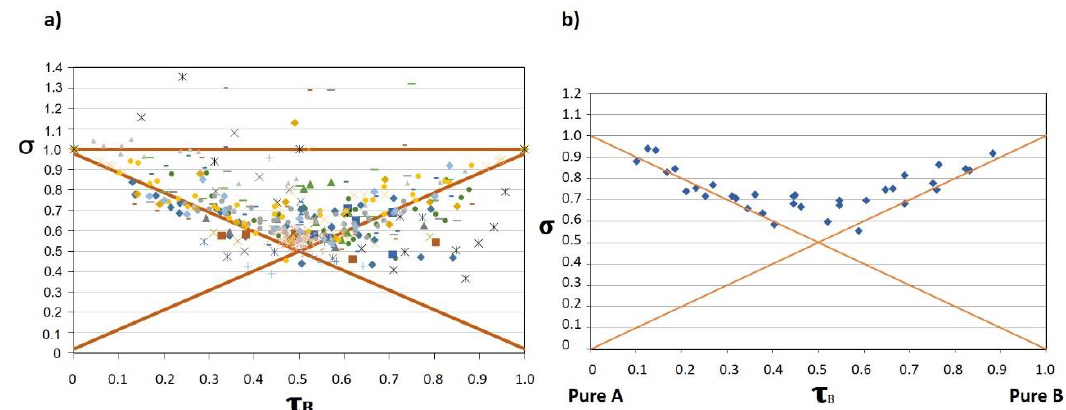
Figure 2. Representation of 520 different mixtures derived from 198 pairs of AB odorants reported in the scientific literature and compiled by Ferreira [30]. ( a ) General σ vs. τ plot showing the probability of occurrence of the different interactions; ( b ) most probable representation for a σ vs. τ B according to a real mixture pyridine/butanol proposed by Olsson [32]. Adapted with permission from ref. [30].